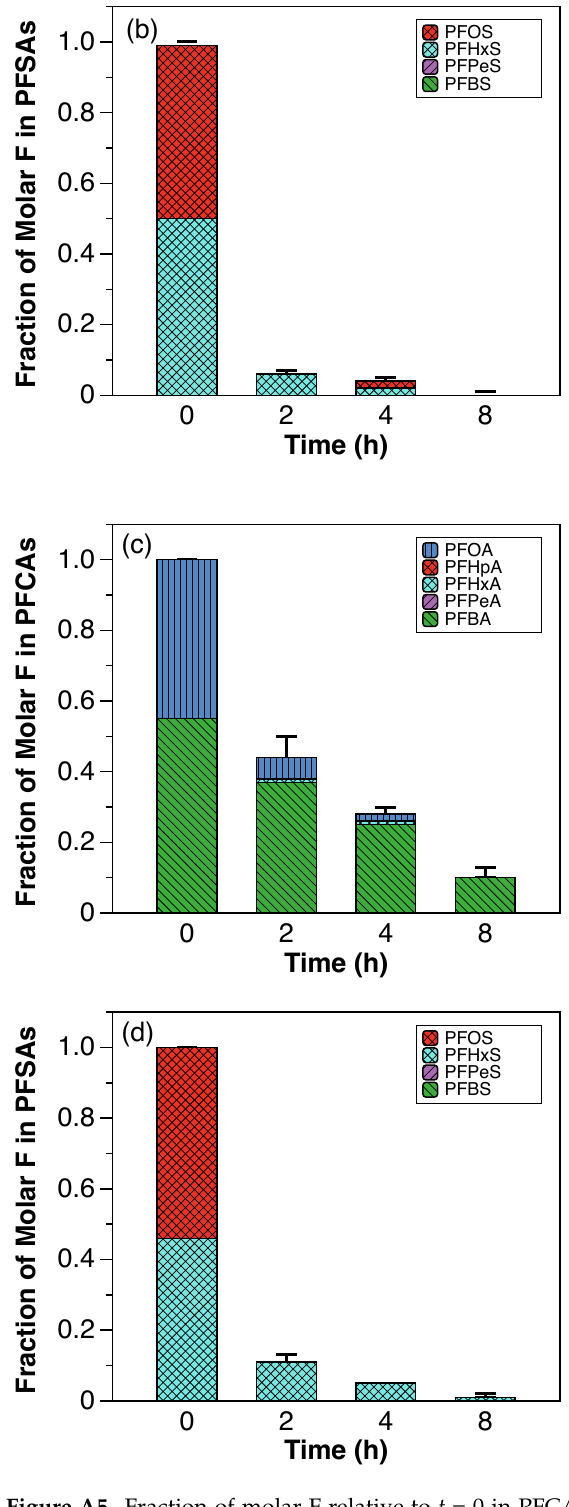
Figure A5. Fraction of molar F relative to t = 0 in PFCAs and PFSAs during the electrochemical oxidation of a synthetic still bottoms solution with 50 mA/cm 2 . ( a , b ) correspond to experimentation at the laboratory scale. ( c , d ) correspond to experimentation at the semi-pilot